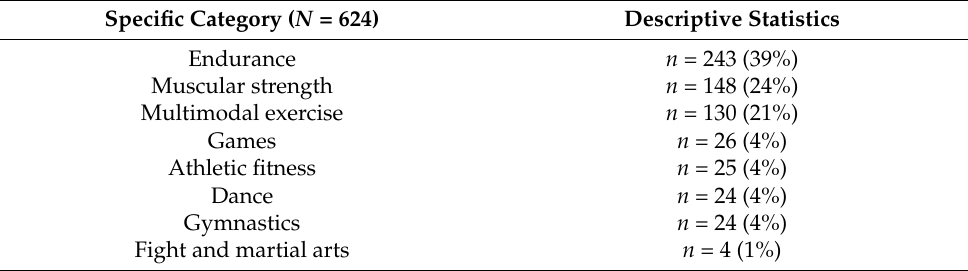
Table 3. Types of exercises chosen by “new